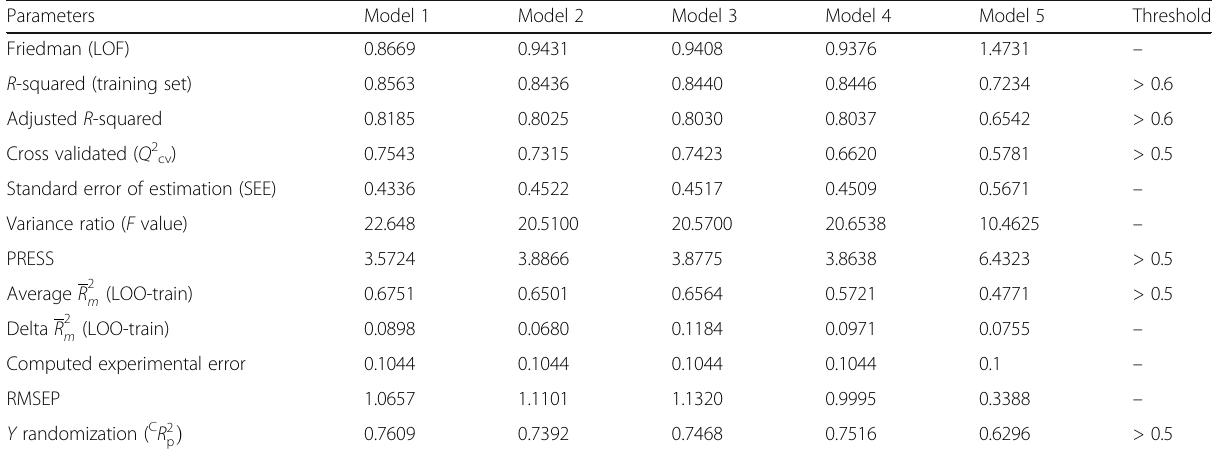
Table 2 Internal validation of the five (5) QSAR models